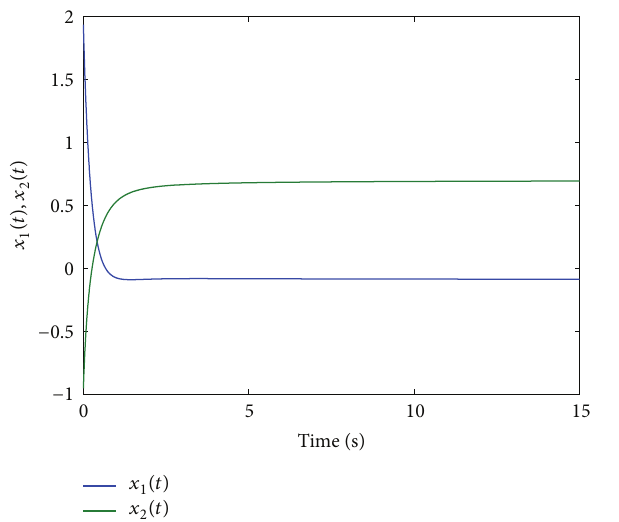
Figure 1: The dynamic behavior of system